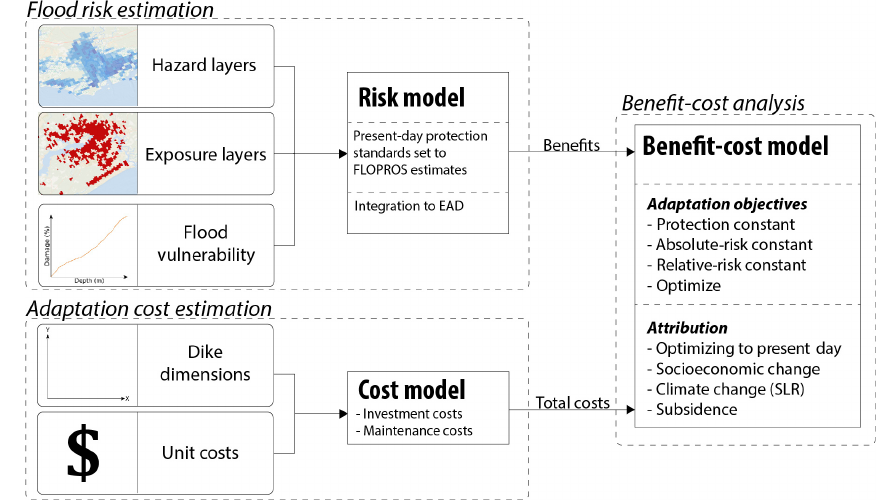
Figure 1. Overview of models and data layers for assessing flood risk, costs of adaptation, and attribution of different drivers.